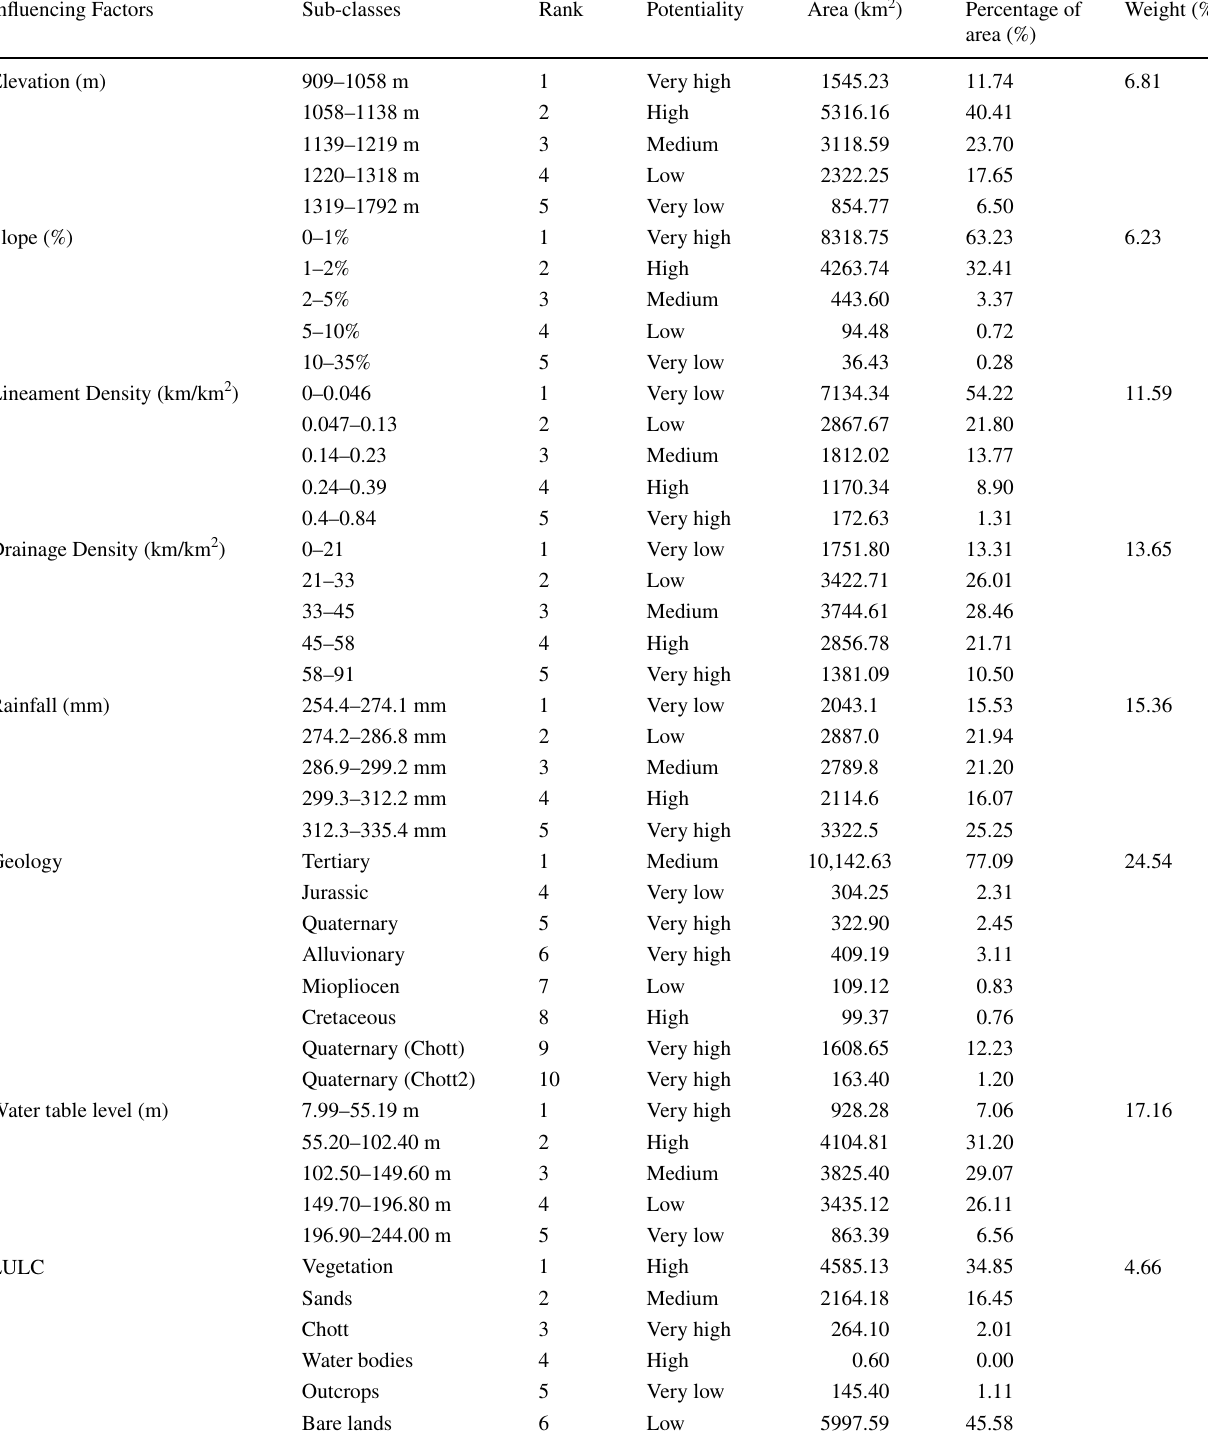
Table 4 Classification of weights of influencing factors Influencing